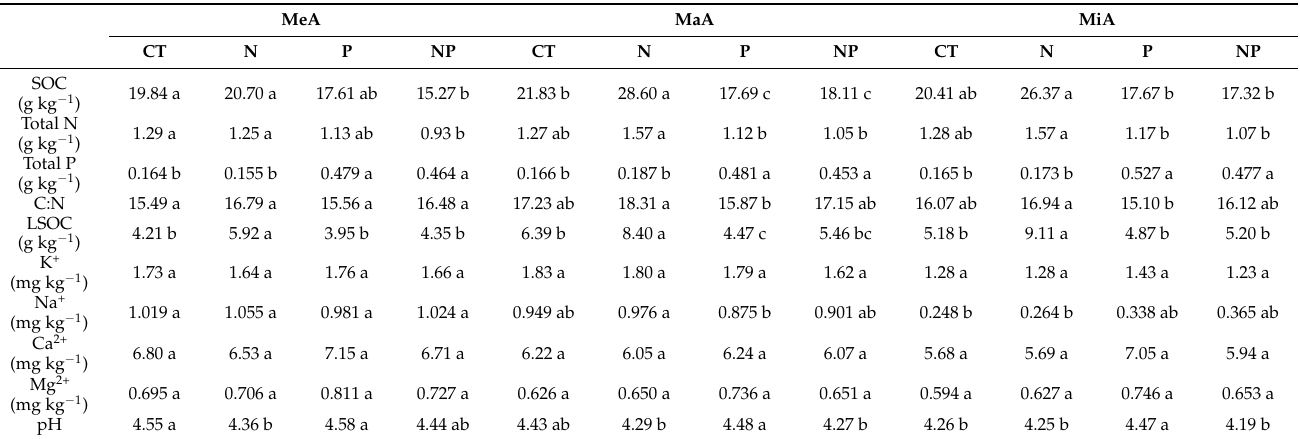
Table 1. Effects of N and P fertilization on chemical properties in different size aggregates in a Cunninghamia lanceolata forest.